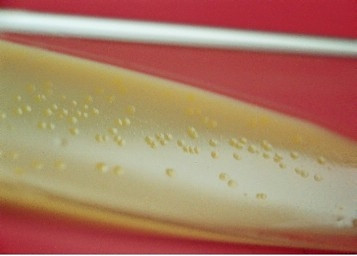
Pigmented ovine isolate. Pigmented colonies of Mycobacterium avium subsp. paratuberculosis on a Lowënstein-Jensen slant, isolated from the yellow-colored intestines of one sheep with clinical paratuberculosis from the Basque Country (Spain).